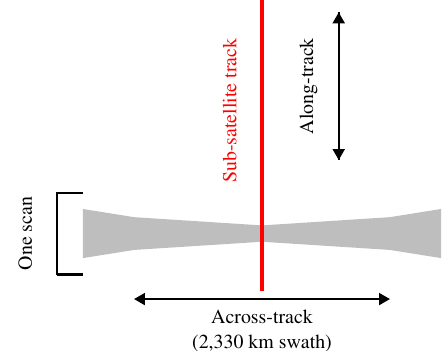
Figure 1. Illustration of some terms related to MODIS scan geom-